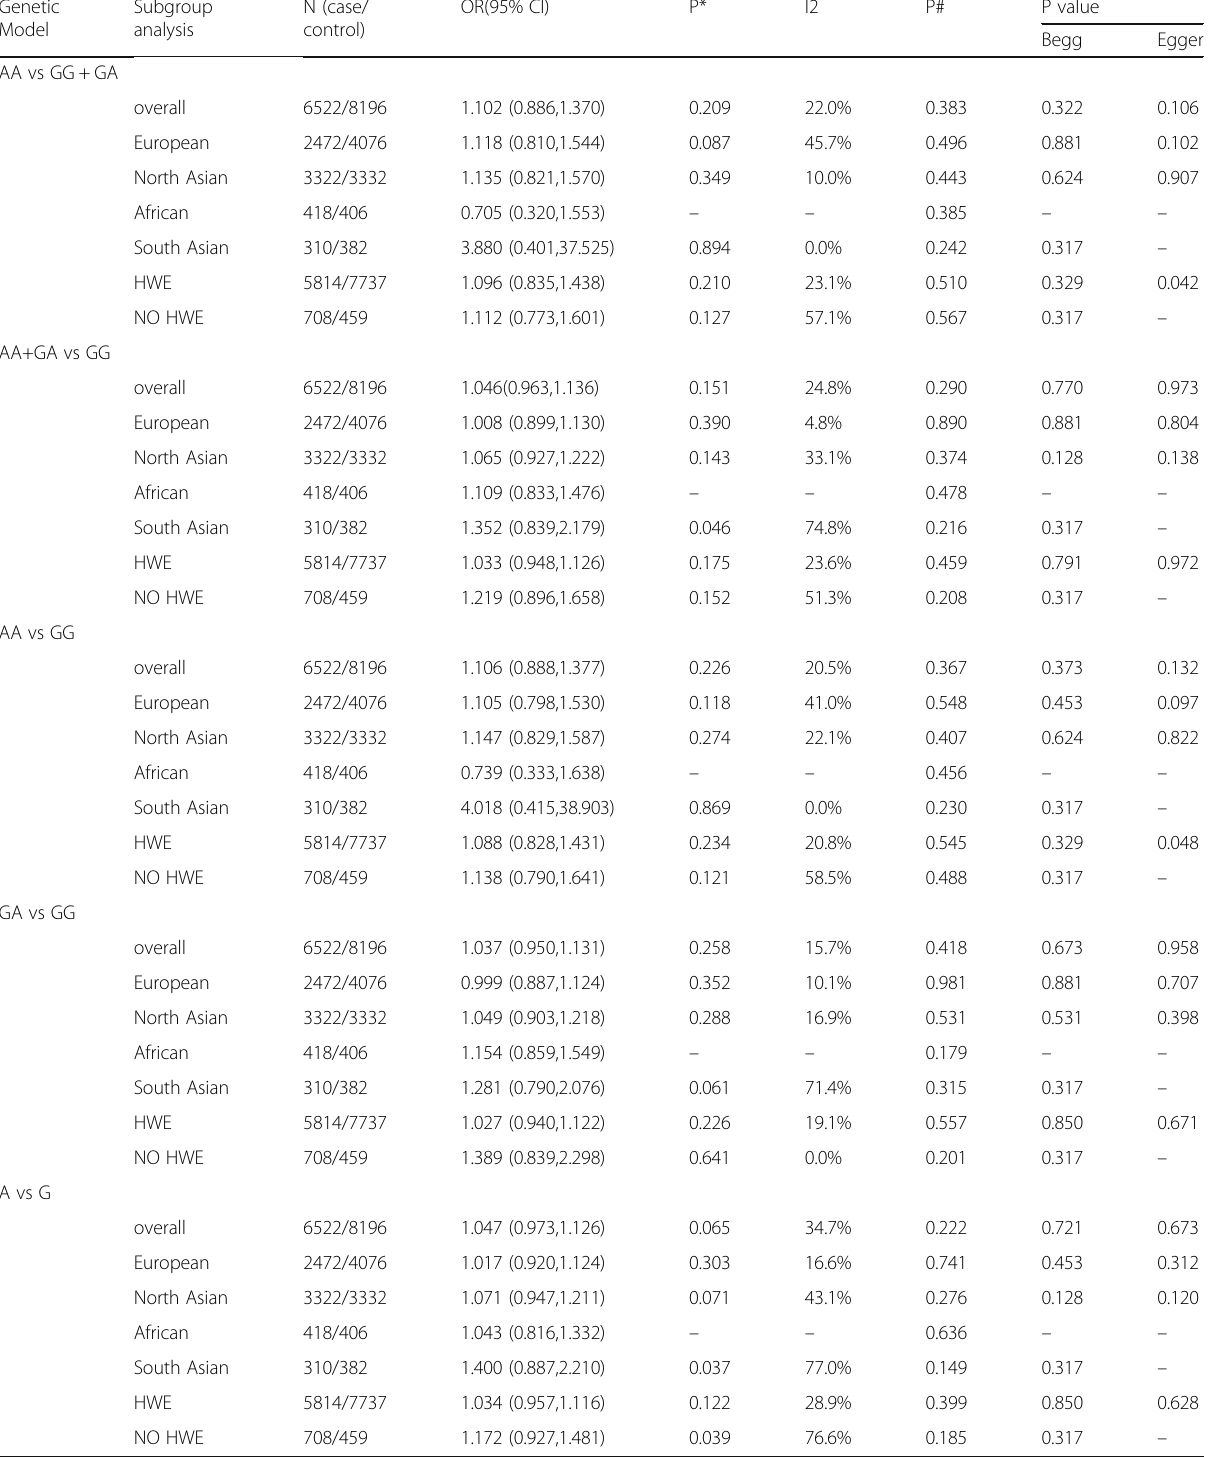
Table 2 Meta-analysis of TNF- α 308G/A polymorphisms and CAD susceptibility Genetic